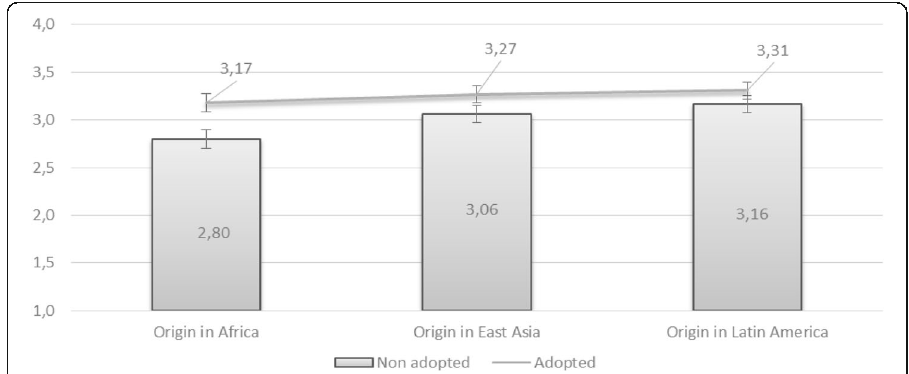
Fig. 4 Social acceptance of interracial marriages: Comparison of white Swedish respondents ’ attitudes towards non-white migrants and transnational adoptees in